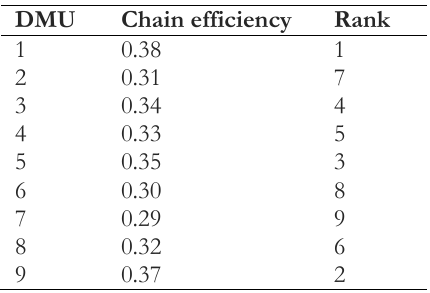
Table 5. Total efficiency of the chain with the proposed model.